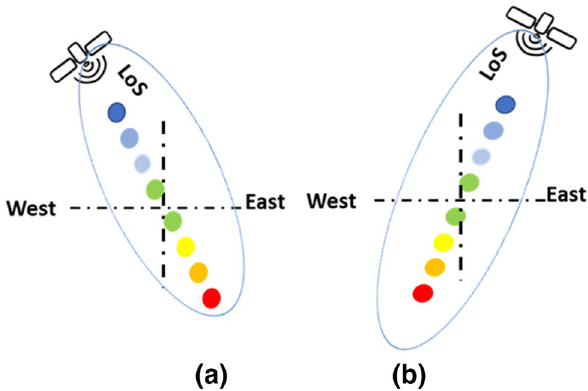
Fig. 4 Geometry acquisition: a Ascending; b